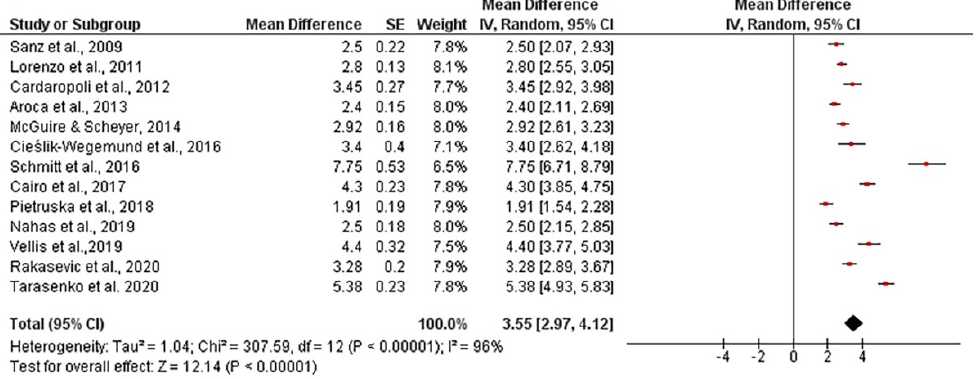
Figure 6. Forest plot for keratinized mucosa width when collagen matrix was used. Weighted mean is presented at CI 95%. Heterogeneity was determined using Higgins (I 2 ). A random-effects model was applied. Statistical significance was p < 0.001.